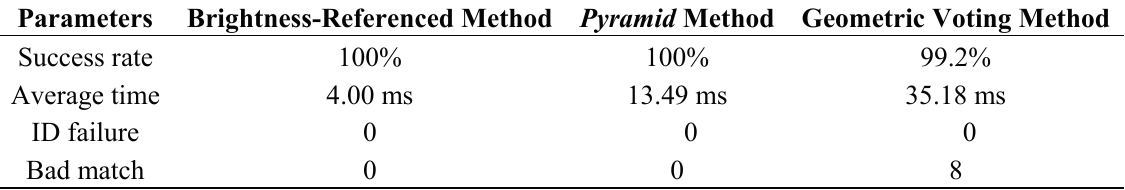
Table 4. Results of the tree methods with on-orbit